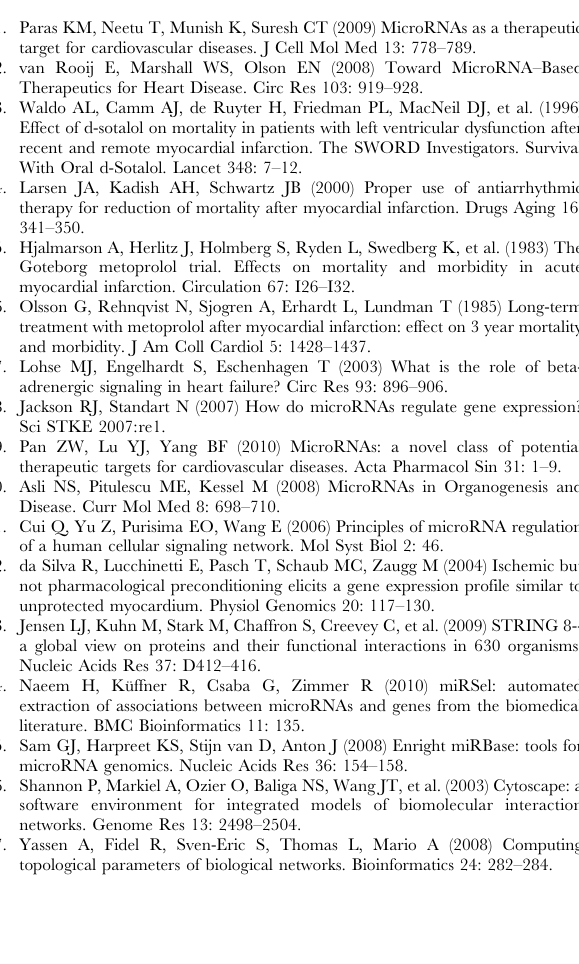
Table S2. The percentage of experimentally validated and high confidently predicted target genes (p-value ,